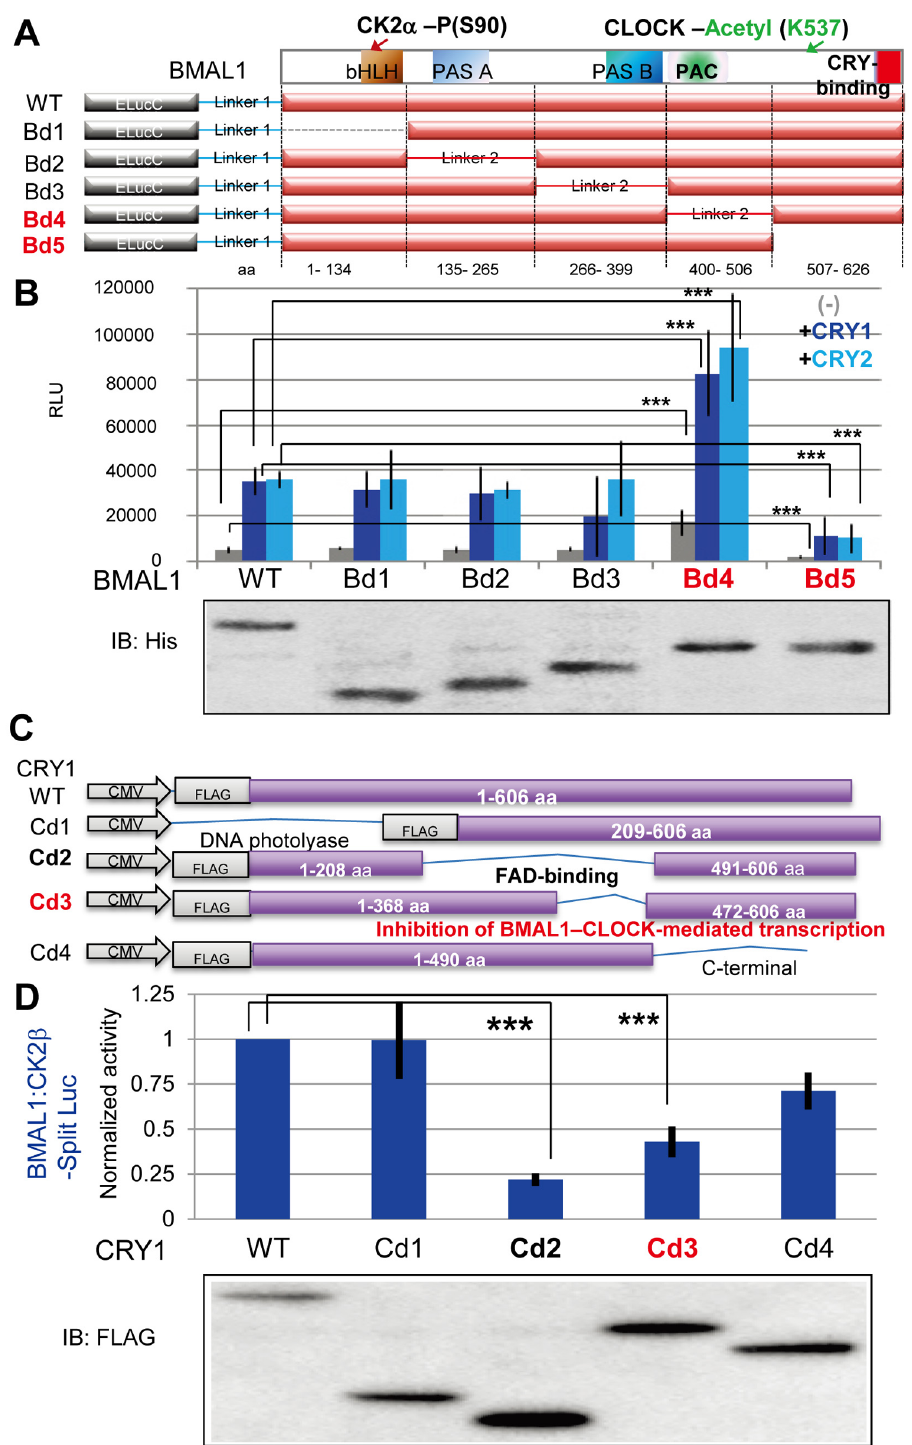
Fig 5. Identification of CRY1 and BMAL1 regions involved in CRY-enhanced BMAL1 – CK2 β binding. (A) Schematic representation of Split Luc mBMAL1 deletion mutant expression vectors. (B) Cos7 cells were transfected with ELucN-CK2 β and either full length (WT) or mutant (Bd1-5) ELucC-BMAL1, in combination with either pcDNA (-; negative control), Myc-HA-CRY1, or Myc-CRY2. Expression of ELucC-BMAL1-full length and deletion mutants (Bd1-5) was confirmed by immunoblot analysis using anti-His antibody (lower